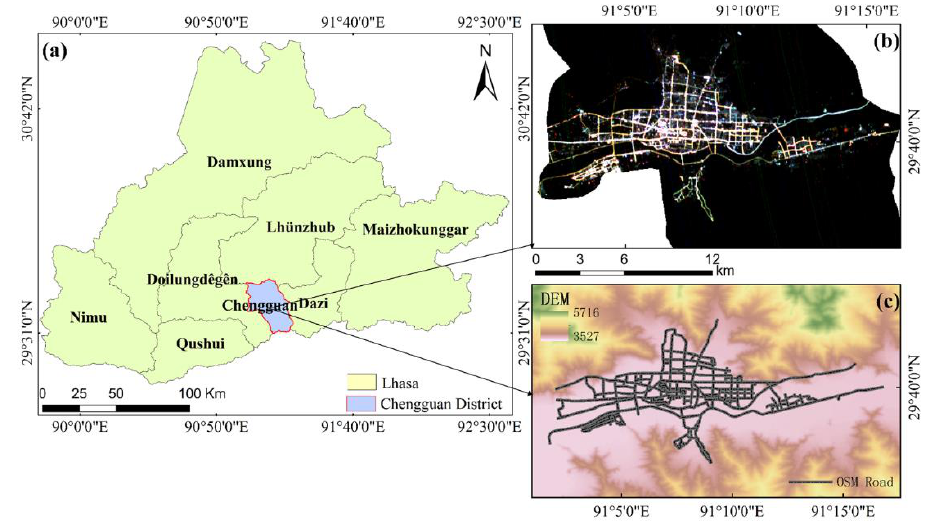
Figure 4. Location map of the test area: ( a ) location of test area, ( b ) SDGSAT-1 nighttime light data, and ( c ) OSM road network data.